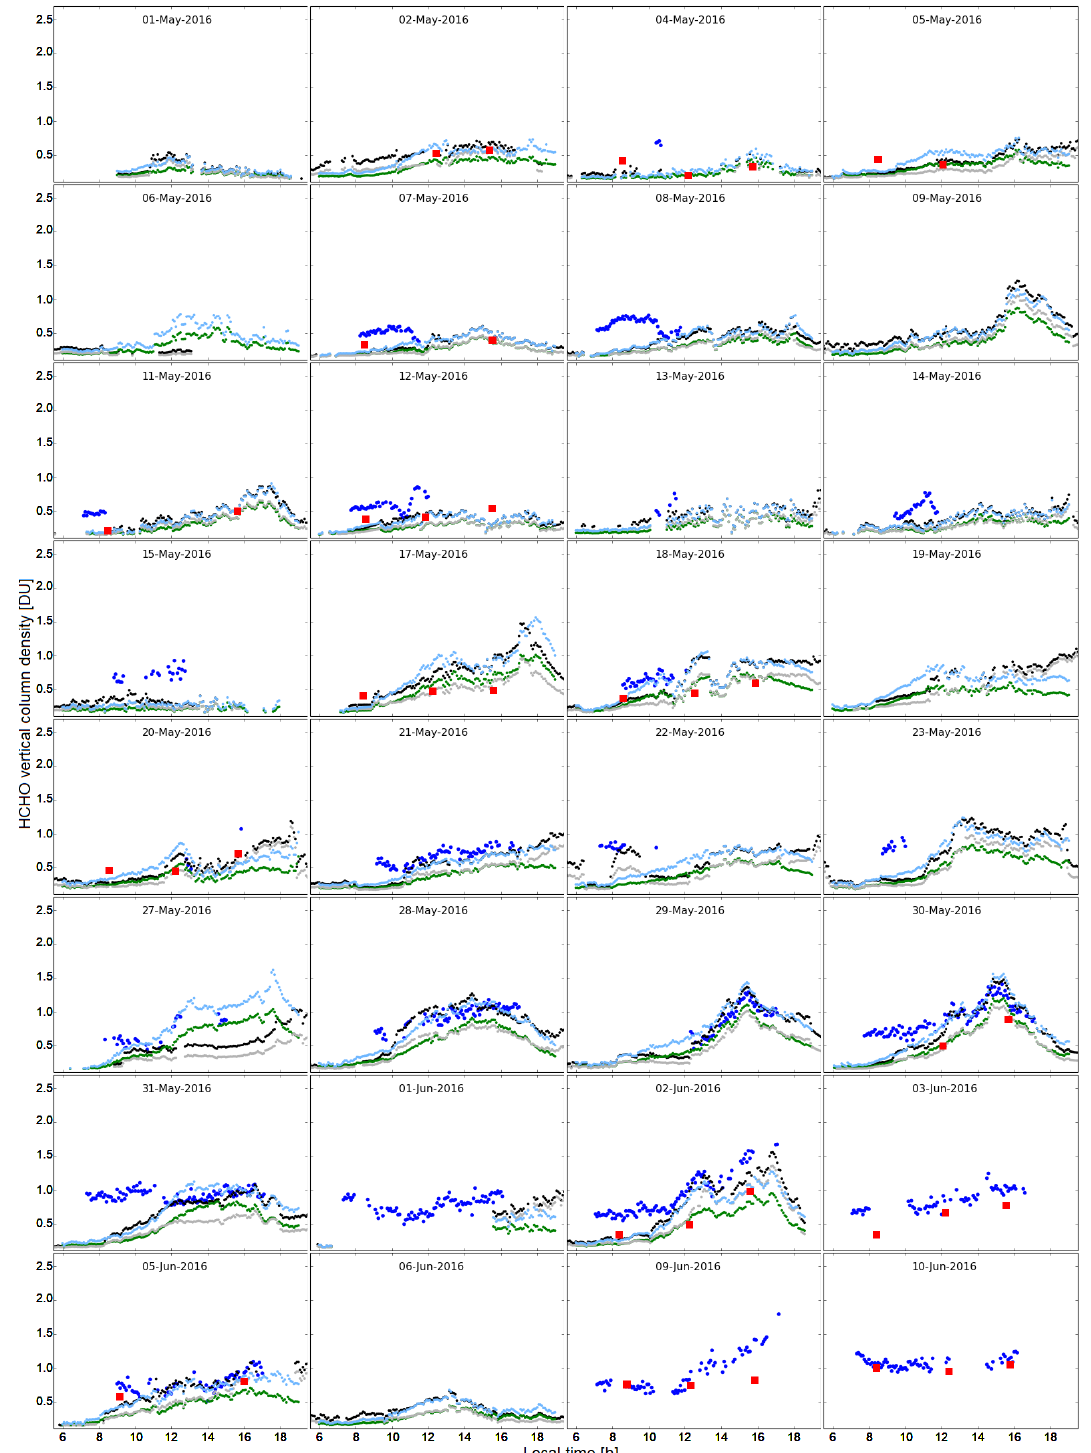
Figure 8. Vertical column densities at Mt. Taehwa during KORUS-AQ derived from Pandora direct-sun measurements ( • ); DC-8 (from surface to 12.77km, (cid:4) ); and surface concentrations and profile shapes: (1) box with a median MLH (green), (2) box with a measured MLH (grey), (3) box + exponential profile with a median MLH (light blue), and (4) box + exponential profile with a measured MLH